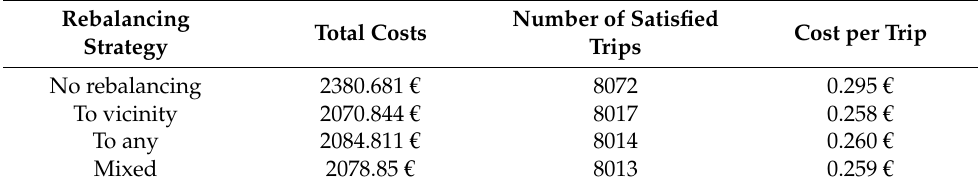
Table 7. Total costs for the different rebalancing options.